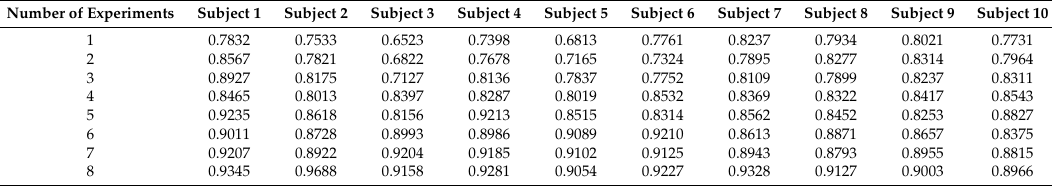
Table 2. The similarity between the autonomous return track and the experimental original track.